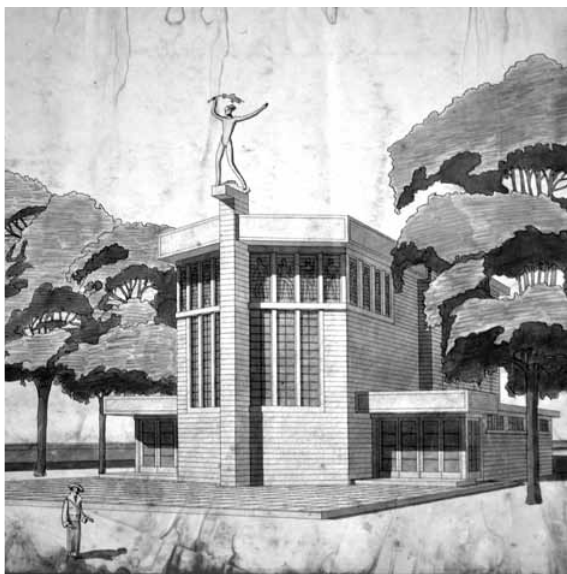
fig. 4. j. Gočár, Czechoslovak Pavilion at the Paris fig. 6. j. Gočár, Project for Protestant church in louny,